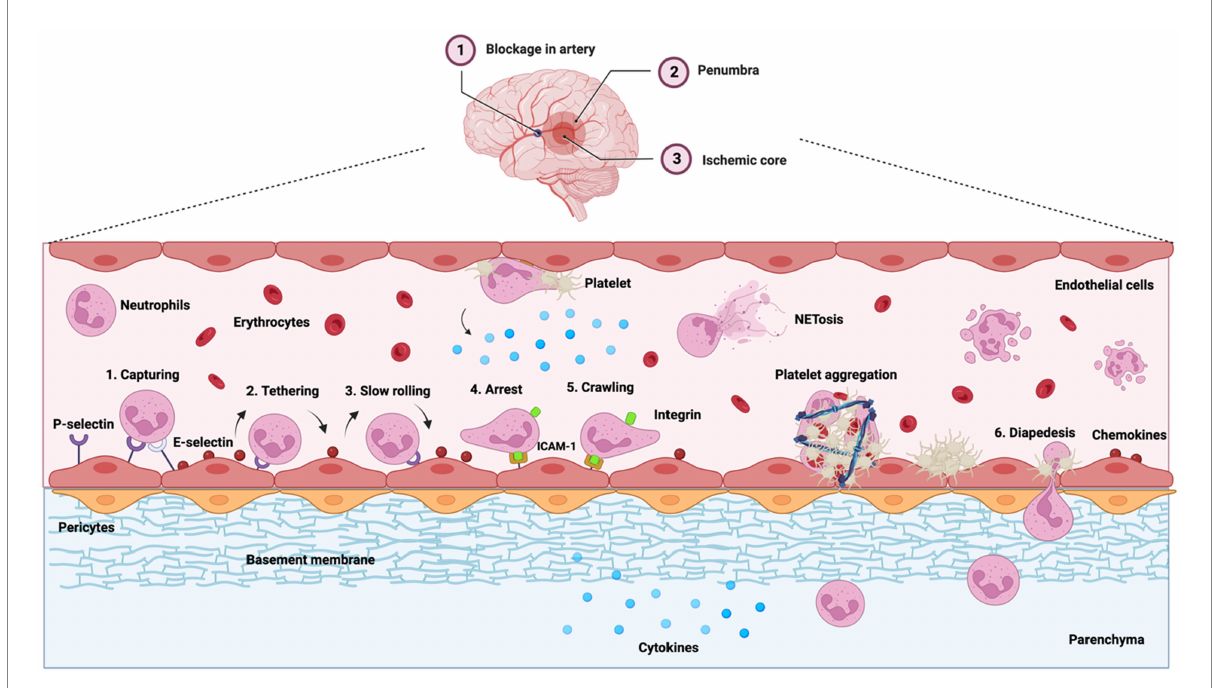
FIGURE 1 Leukocyte (neutrophil) extravasation and infiltration during inflammation are major contributors to poor ischemia outcomes. Middle cerebral artery occlusion is illustrated. During inflammation, cytokines (IL-1 β , IL-6, and TNF- α ) and the chemokines (MIP-1, MIP-2, and MCP-1) are upregulated, which stimulate the expression of selectins and ICAM-1 on the endothelial surface near the ischemic area. Chemokines (blue dots) are transcytosed through or deposited on the endothelium. E-selectin and P-selectin capture neutrophils from the blood flow, pulling the tethers at the rear of neutrophils and initiating their rolling motion. This activates integrins on neutrophils that firmly attach to ICAM-1, causing neutrophil adhesion. Neutrophils also recruit platelets, causing platelet aggregation and blocking the flow of red blood cells (erythrocytes). Neutrophils then infiltrate into the perivascular space through diapedesis while continuing to release pro-inflammatory factors into the ischemic area, causing neuronal